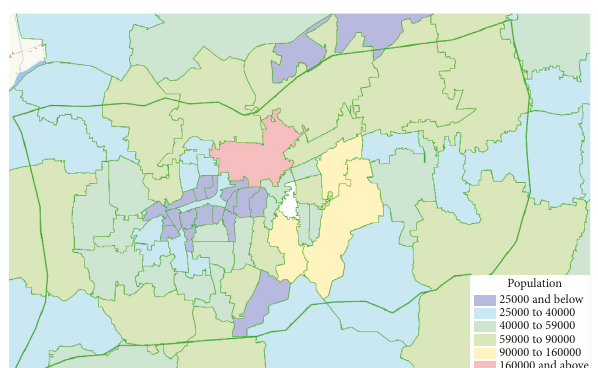
Figure 5: Population distribution of study area.